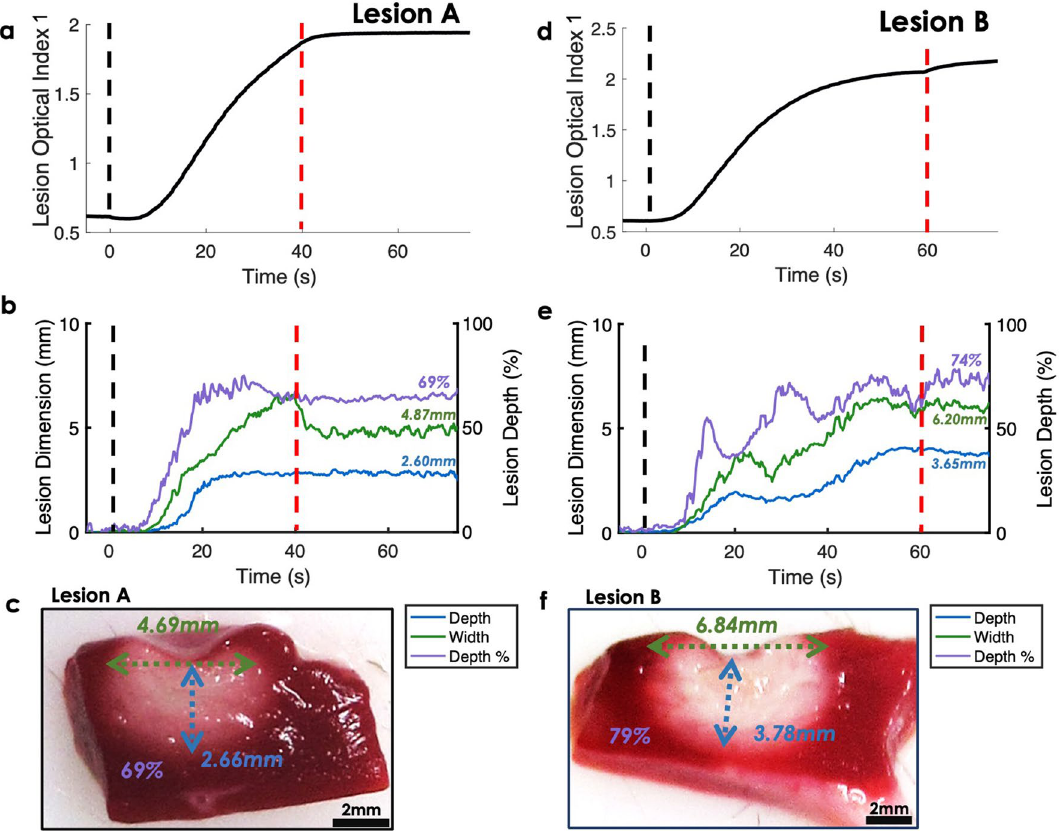
Figure 5. Representative samples for real-time lesion size approximation ex vivo. ( a , d ) Show recorded lesion ∧ 2 (cid:31) ), [ ∧ optical index (LOI 1 = 1 , ∧ 2 ] = [600 nm, 1000 nm]) changes over time for two different size ∧ 1 R Rel ( lesions. Black and red dashes denote the onset and completion. ( b , e ) Show the corresponding predictions of (cid:31) lesion depth, width, and depth percentage, along with the resulting TTC stained lesion for comparison in ( c ) and ( f